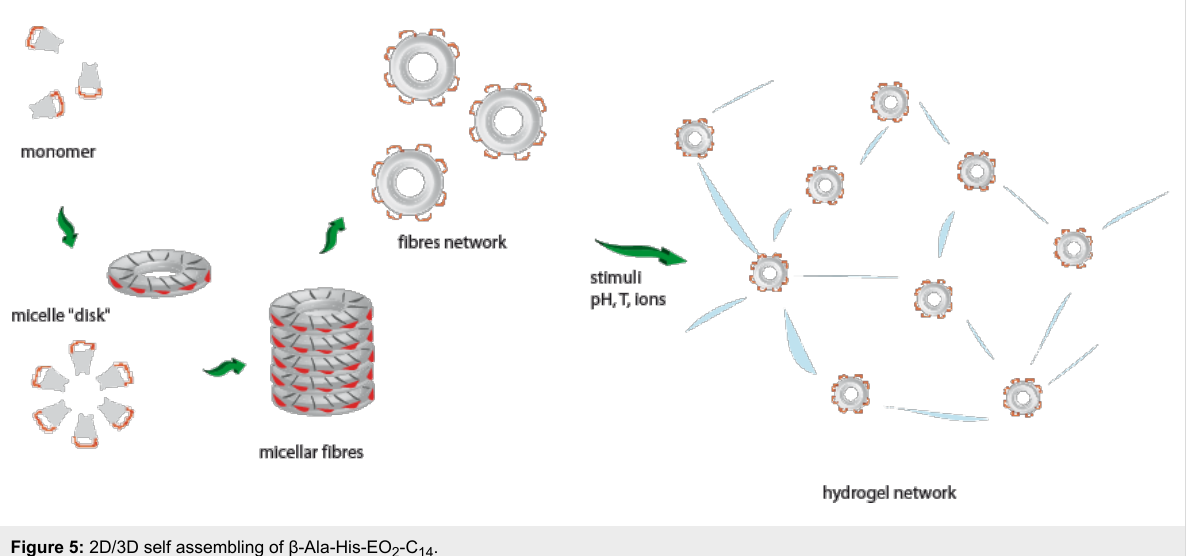
Figure 5: 2D/3D self assembling of β -Ala-His-EO 2 -C 14